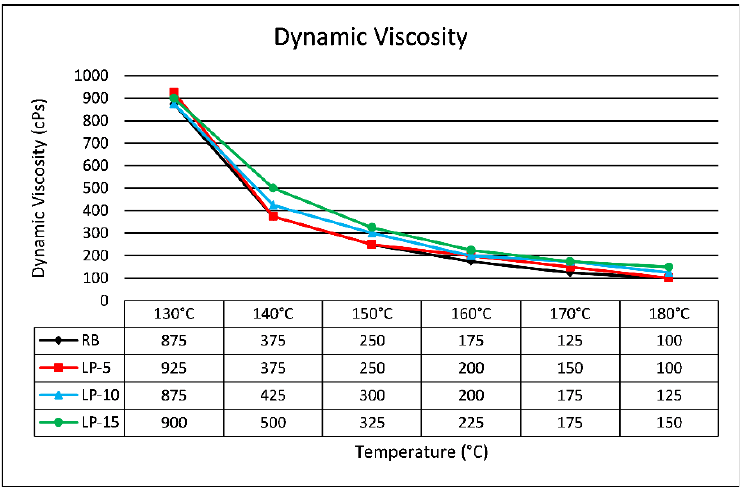
Figure 15. Dynamic viscosity values of the four blends at different temperatures .